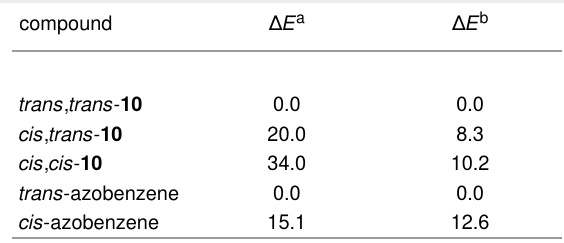
Table 1: Relative energies [kcal/mol] of the isomers of 10 and azoben- zene calculated using different